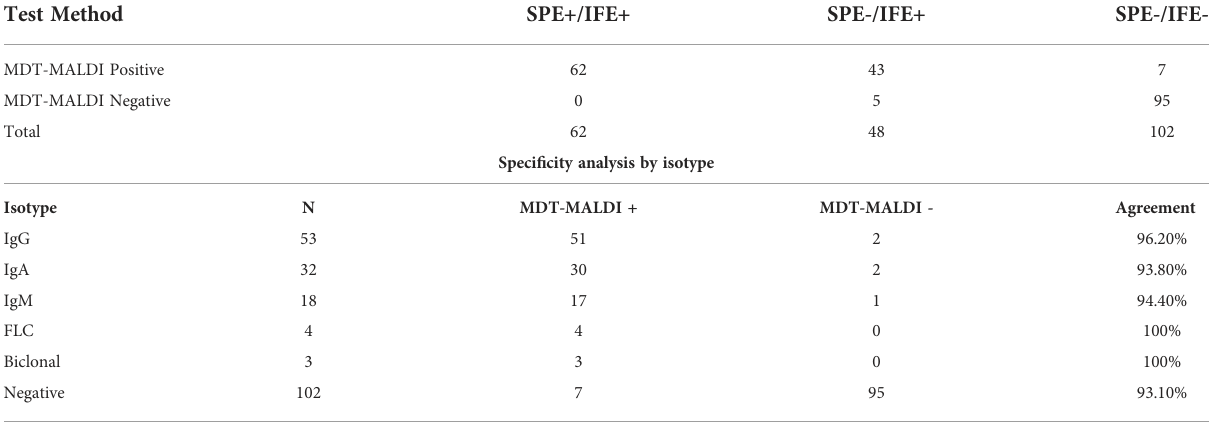
TABLE 1 Comparison between MDT-MALDI and